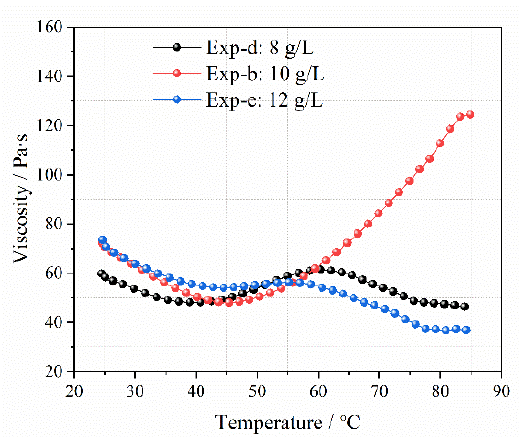
Figure 10. Colloid elastic modulus with increasing temperature at different contents of LMP.